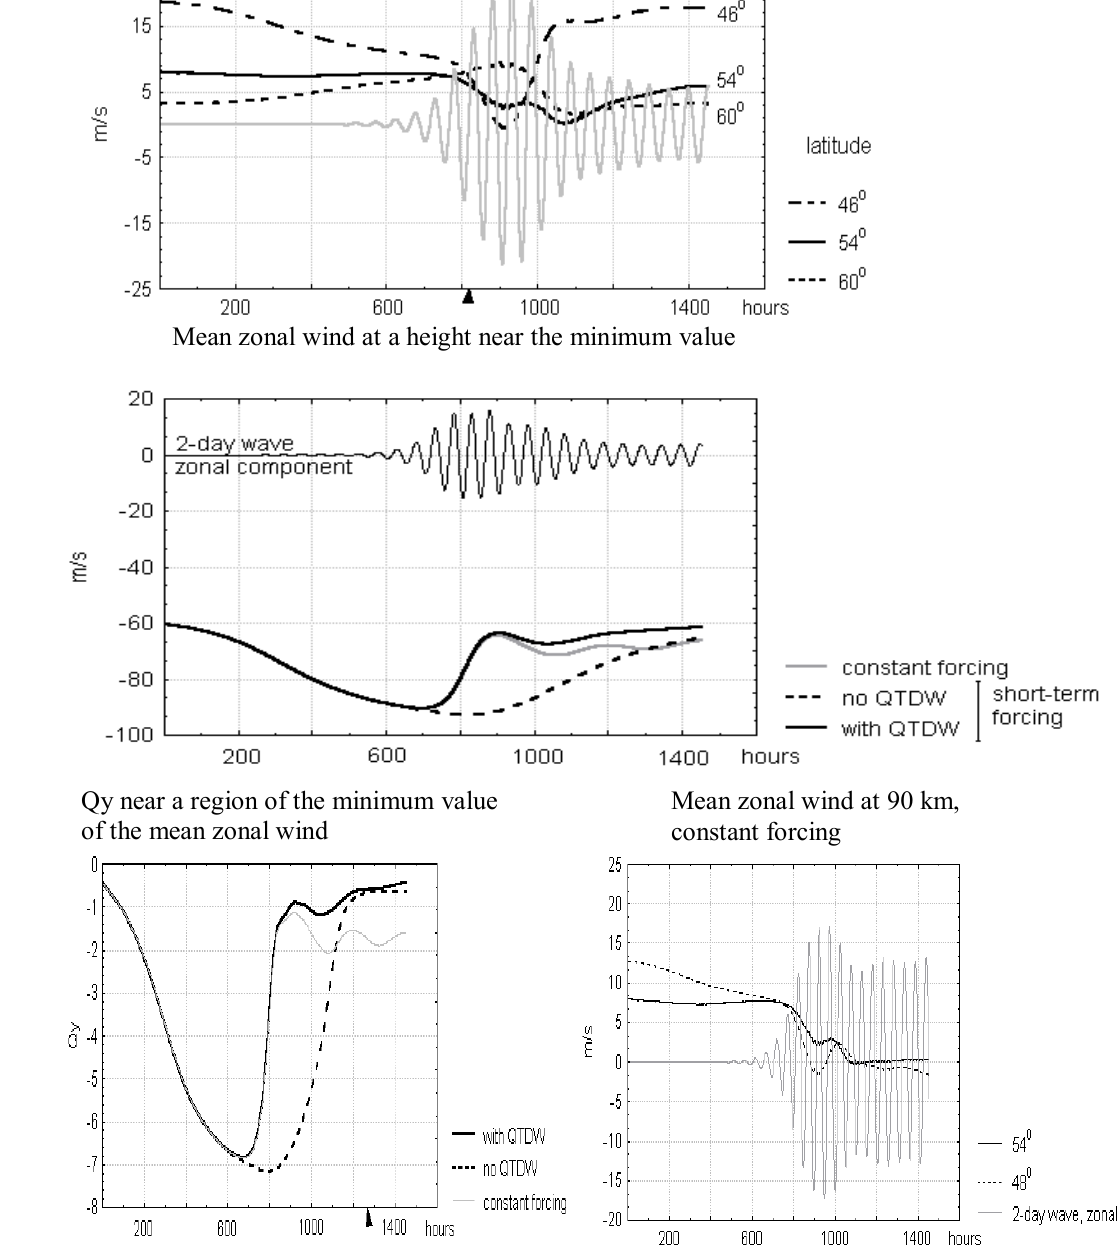
Fig. 2. (Top) variations of mean zonal wind at different latitudes at 90km, and the meridional QTDW wind (divided by a factor of 2); (middle) zonal mean zonal wind and QTDW amplitude at the height and latitude of the maximum easterly jet (zonal component of the QTDW is added; (bottom, left) as previous one but for the latitudinal gradient of the potential vorticity; (bottom, right) mean zonal wind at 90km under conditions of the constant forcing. Arrows point at time moments for which the distributions of the next figure were